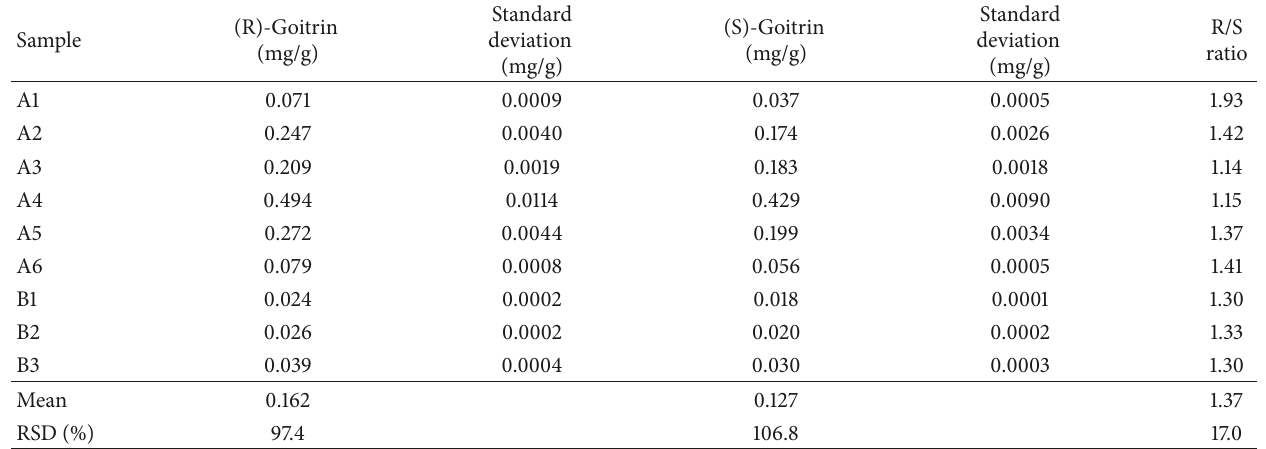
Table 3: Contents of (R)- and (S)-goitrin in 9 batches of Banlangen granules ( 𝑛 = 3